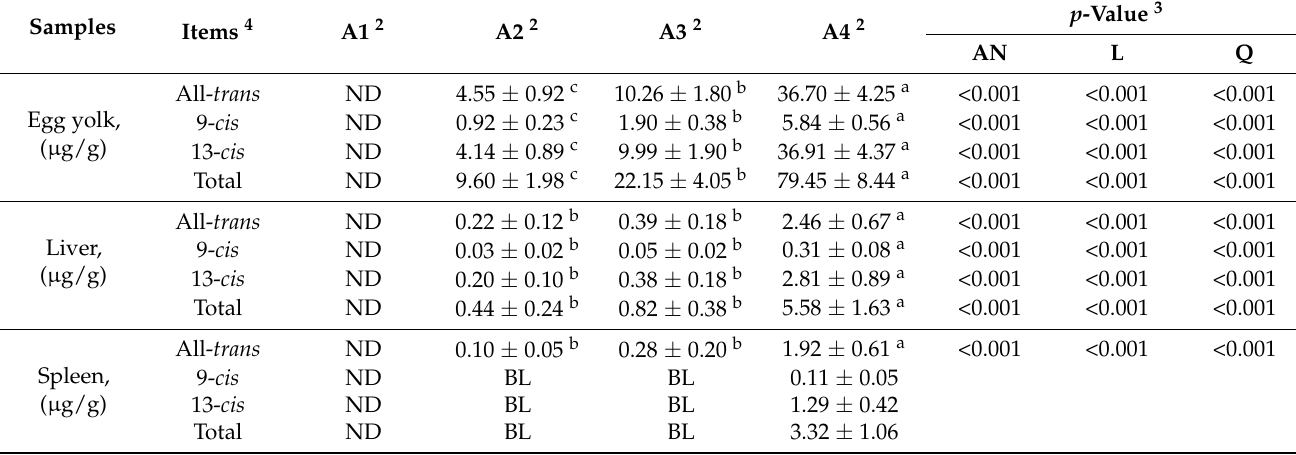
Table 3. Astaxanthin content in egg yolk, liver, and spleen of laying hens on week 12 (mean ± STD 1